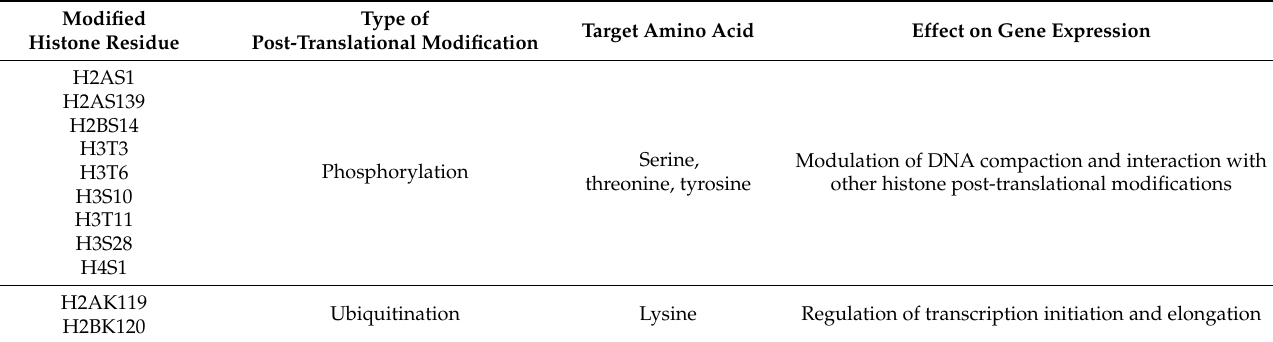
Table 2. Main post-translational modifications of histones and targeted residues. Effects on gene expression are reported. Adapted from Lachat et al. (2018)